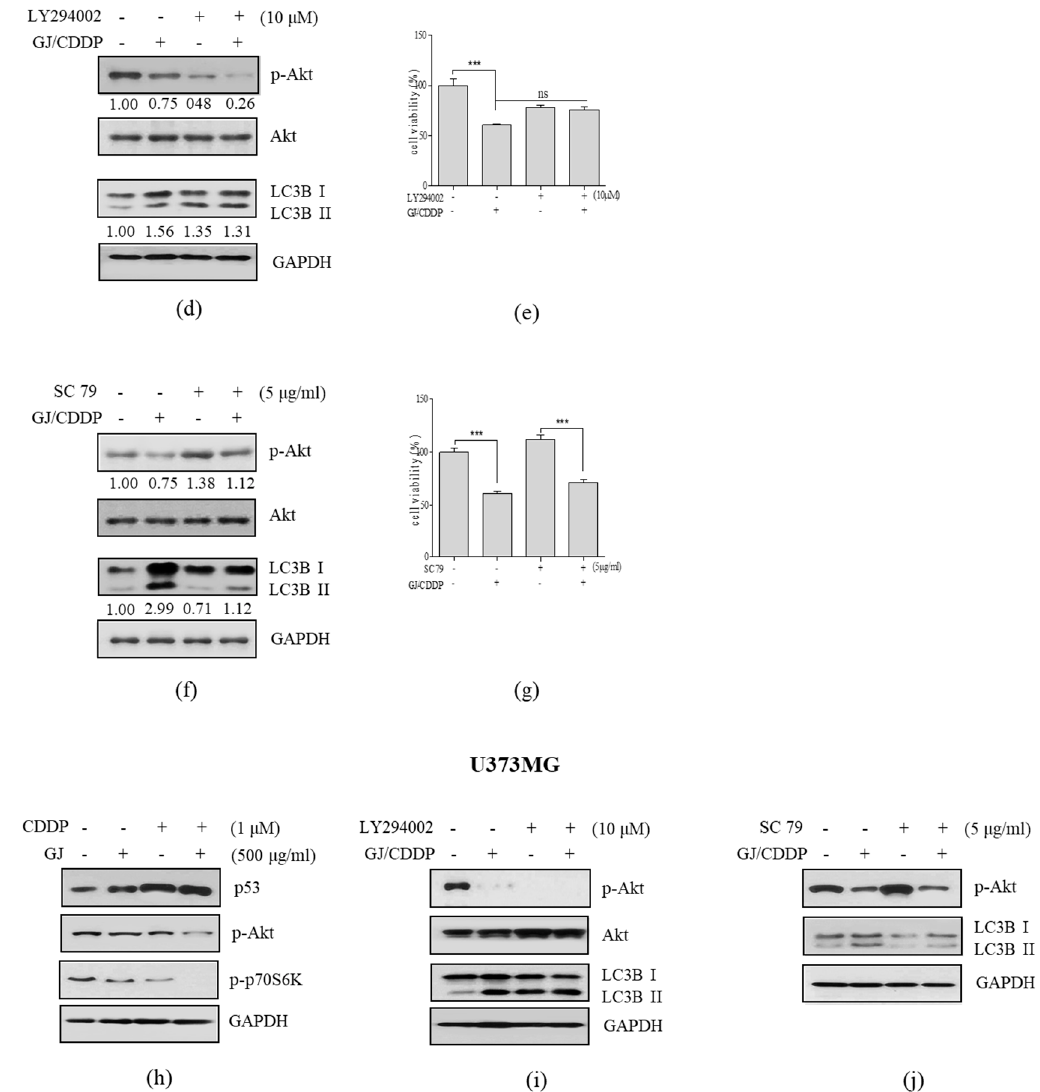
Figure 6. Effect of GJ/CDDP combination on AKT/mTOR pathway in U87MG and U373MG cells. Western blot assays on ( a ) p53, ( b ) p-AKT, and ( c ) p-p70S6K were performed in GJ/CDDP combination-treated U87MG cells. ( d ) Western blot assays on p-AKT and LC3B-I/II, and ( e ) an MTT assay were performed in GJ/CDDP combination-treated U87MG cells after pre-treatment with LY294002. ( f ) Western blot assays on p-AKT and LC3B-I/II, and ( g ) an MTT assay was performed